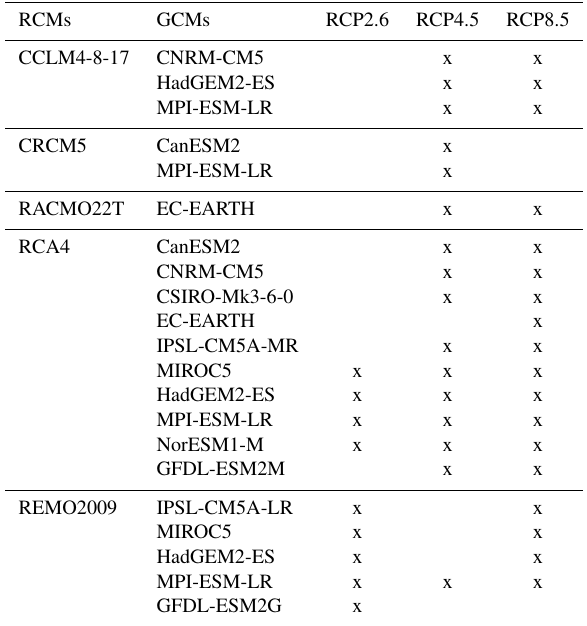
Table 1. List of the CORDEX-Africa general circulation models (GCMs) datasets downscaled by regional climate models (RCMs) and their availability per Representative Concentration Pathways (RCPs) marked with a cross